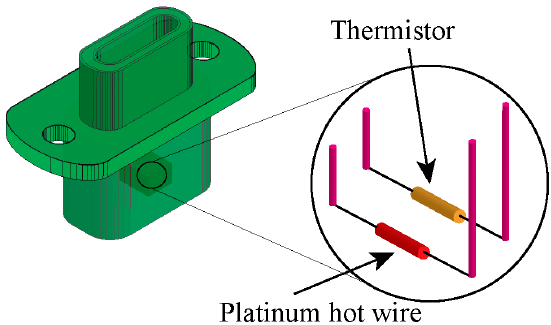
Figure 3. Mass air flow sensor for Toyota vehicles.